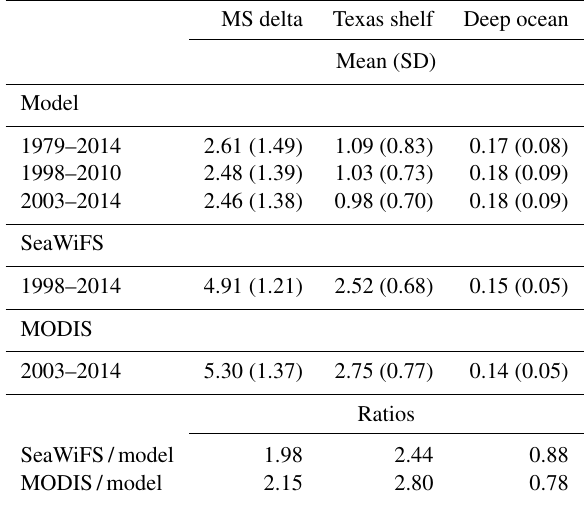
Table 2. Long-term mean and standard deviation of model and satellite